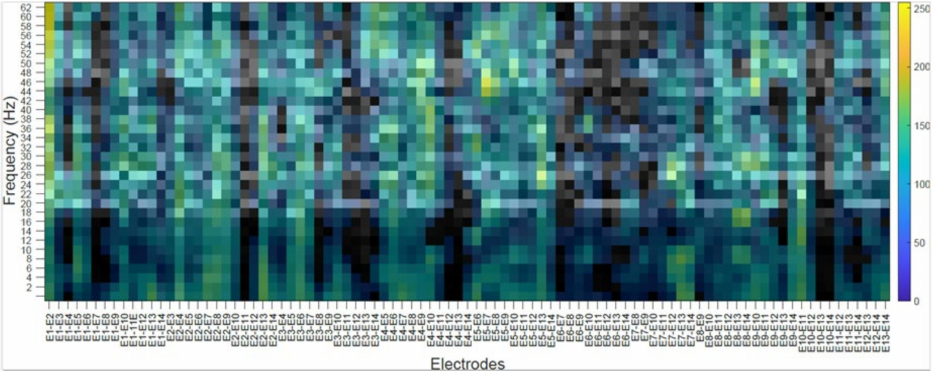
Figure 9. Subject’s internal representation (CAM) in imagined tasks of the vowel /e/. The horizontal axis represents, the difference between electrodes and the vertical axis, the corresponding frequencies.